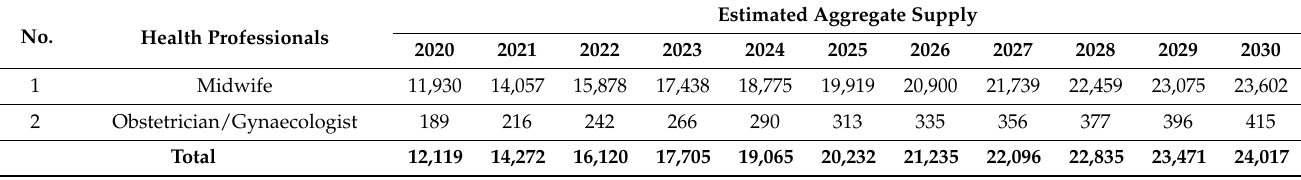
Table 2. Needs-based requirements for midwives, and obstetricians and